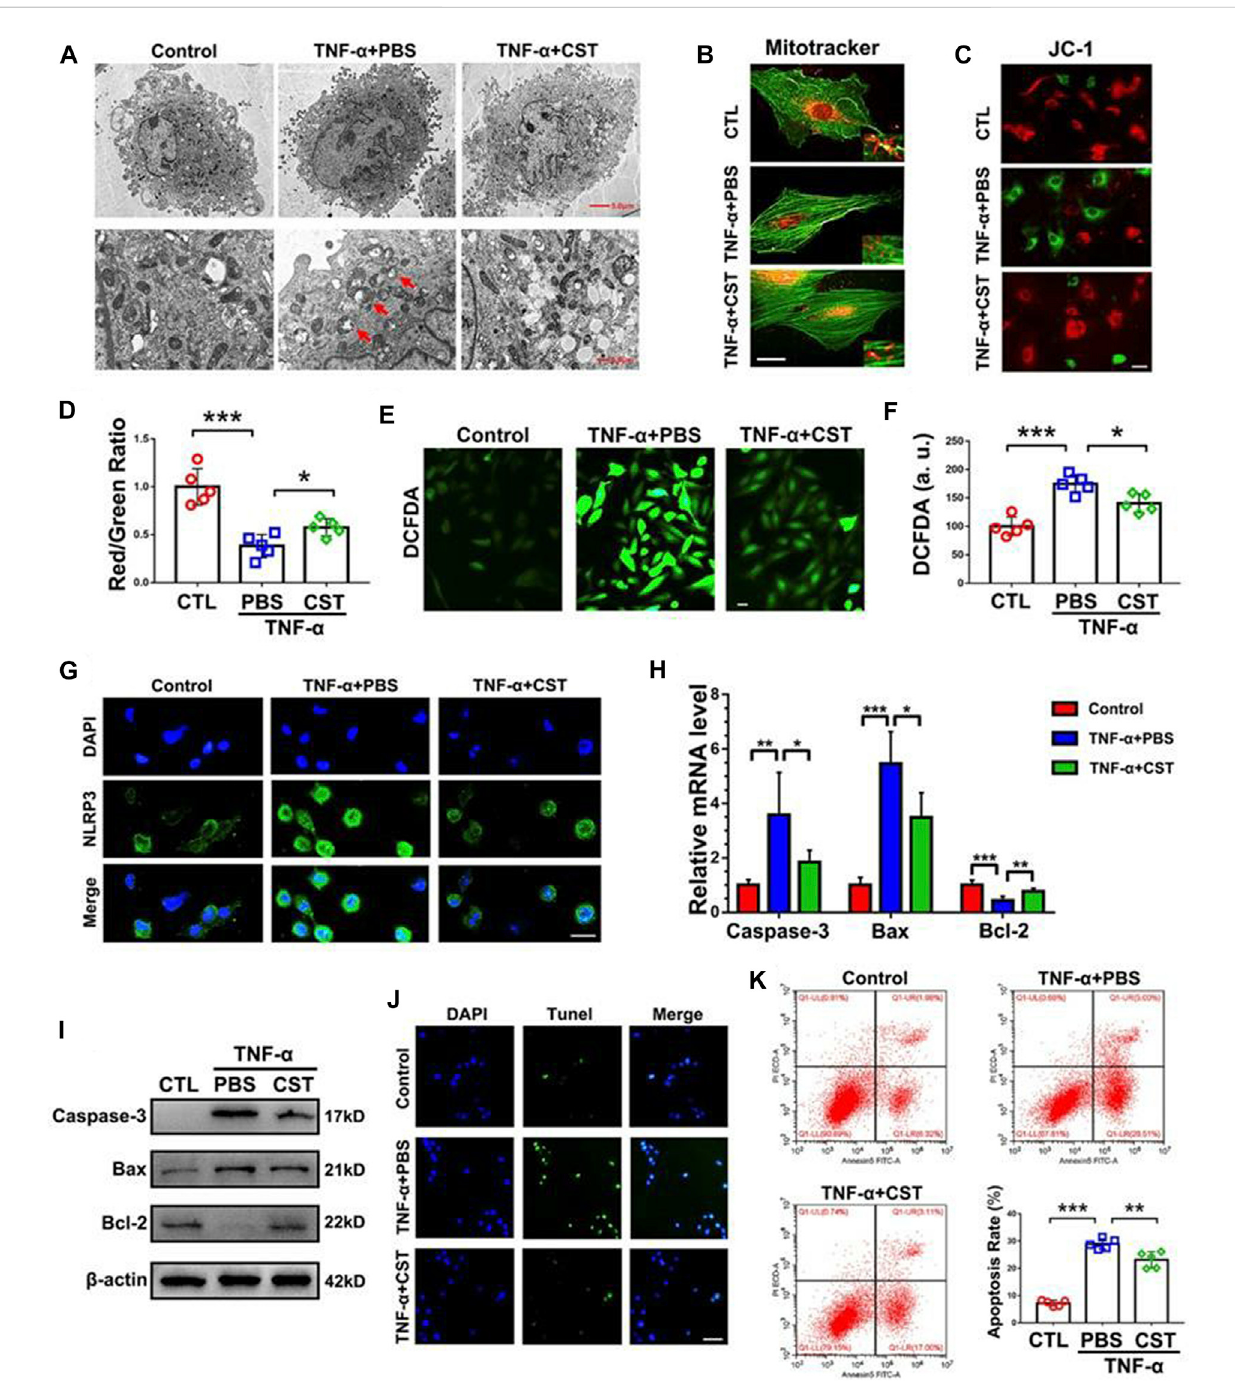
FIGURE 2 Comparison of human NP cells between groups under transmission electron microscopy (A) MitoTracker staining for mitochondria and phalloidin for cytoskeleton (B) , scale bar = 10 μ m. Comparison of JC-1 assay images between different groups (C) , scale bar = 20 μ m. Quantitative comparison of red and green fl uorescence in JC-1 assays (D) . Images of iNOS as determined by DCFDA staining (E) , scale bar = 20 μ m. Quantitative analysis of iNOS content (F) . Comparison of NLRP3 staining in different groups (G) , scale bar = 20 μ m. Comparison of the caspase-3, Bax, and Bcl-2 mRNA levels in differentgroups (H) . Westernblotanalysis ofcaspase-3, Baxand Bcl-2 indifferentgroups (I) . Images of TUNEL staining indifferent groups (J) , scale bar = 100 μ m.Comparisonoftheresults ofthenumber ofapoptotic NPs, as measuredby fl owcytometry (K) . “ * ” p < 0.05, “ ** ” p < 0.01 and “ *** ” p < 0.001.CST corticostatin. Reproduced with permission from a previous publication (Zhao et al.,